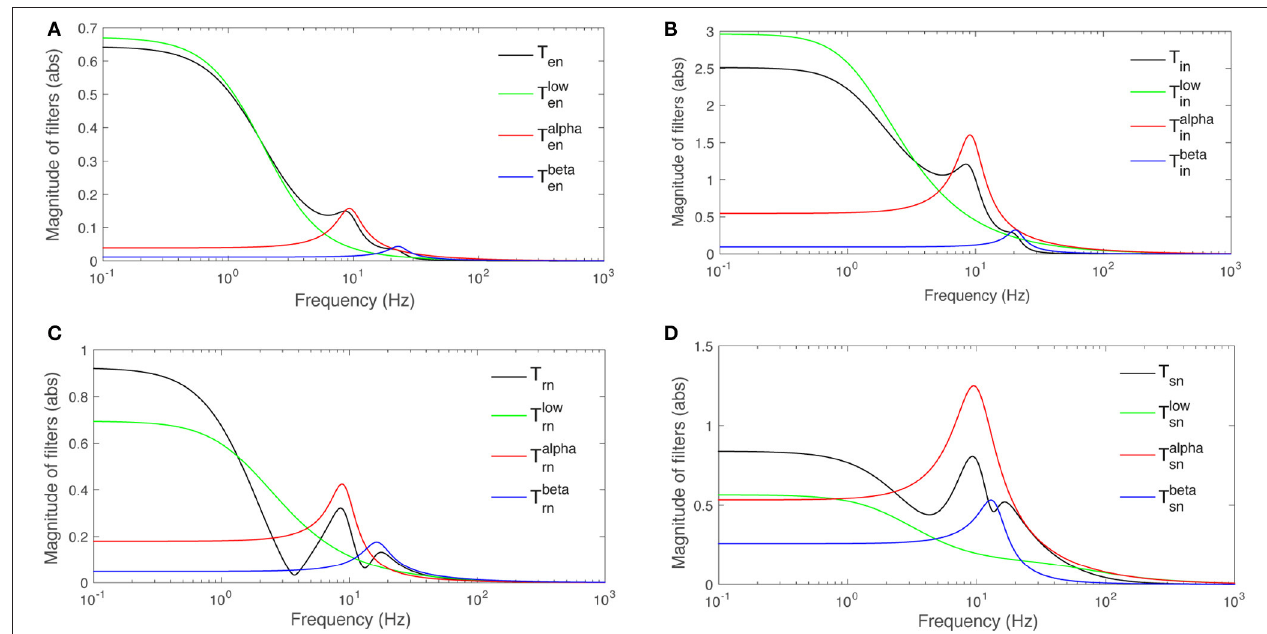
FIGURE 6 | Magnitudes of transfer functions T an and their low-, alpha-, and beta-frequency parts vs. frequency. Note that the total magnitude is not the sum of the magnitudes of the three parts because of phase difference between them. (A) T en . (B) T in . (C) T rn . (D) T sn .